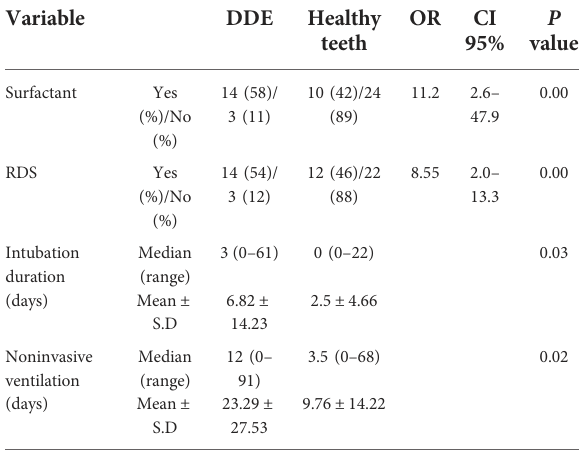
TABLE 2 Developmental defects of tooth enamel in children born preterm and at full term.